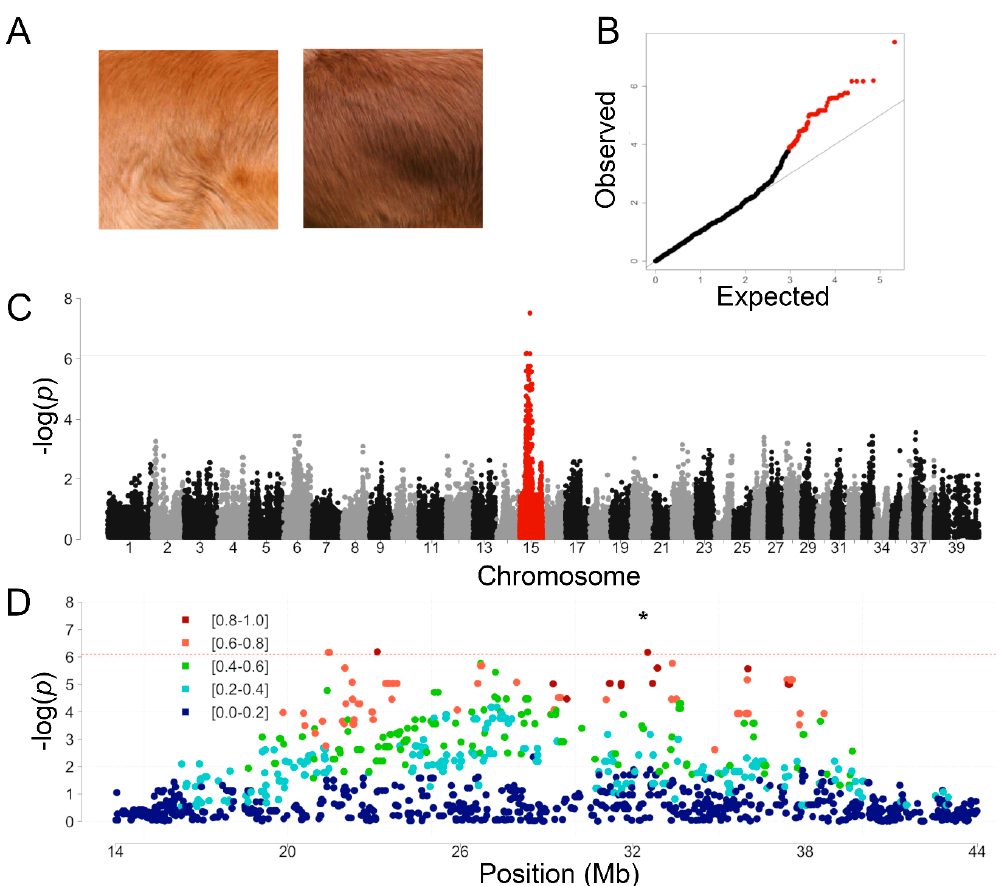
Figure 1. Genome-wide association coat color in the NSDTR . ( A ) Representative NSDTR pictures from light red (left) and dark red (right) coat-colored dogs. ( B ) Quantile-quantile plot from NSDTR GWAS showing a genomic inflation, λ , of 1.03. Chromosome 15 SNVs are highlighted in red. ( C ) Manhattan plot. A single locus on chromosome 15 (in red) reached genome-wide significance after a Bonferroni correction (CanFam2 chr15: 32,383,555, p raw = 3.09 × 10 − 8 , p Bonferroni = 0.0033). Solid line indicates genome-wide significance based on Bonferroni multiple testing correction. ( D ) SNVs from a 30 Mb region surrounding the most associated SNV (black star). SNVs are color coded by the r 2 value to show linkage disequilibrium in the region. Red dashed line indicates the Bonferroni threshold.